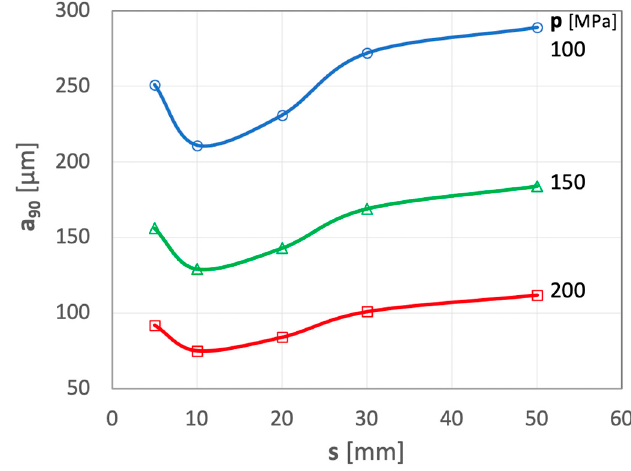
Figure 10. Influence of distance s from the comminuting-homogenizing tube outlet to the comminuting disk on the size of the average dimension a 90 of the comminuted polymetallic nodule particles. Test conditions: d w = 0.7 mm, d h = 2.4 mm.